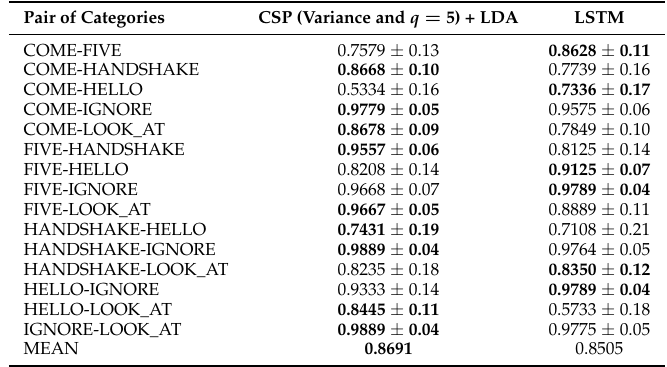
Table 4. Comparison between the proposed approach and LSTM